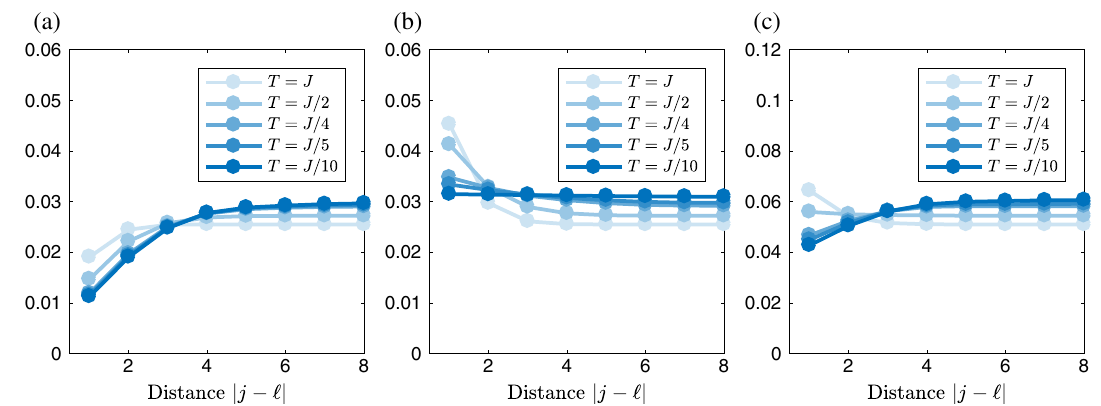
FIG. 4. Extracting the density-density correlation from Eq. (5) in the main text. (a) Density-density correlations in a 1D Bose-Hubbard model at various temperatures. This quantity corresponds to the first term in C ð j; l Þ . (b) Additional contribution to C ð j; l Þ arising from the second term. Crucially, this contribution exhibits decreasing distance dependence in the low-temperature limit. (c) The position dependence of the total value C ð j; l Þ is dominated by the first term in